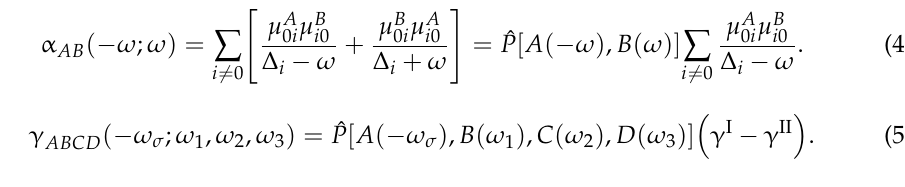
Figure 9. Vibration modes of [12,12]CNB at 929.5, 1360.3, 1482.7, 1565.3, and 3198.8 cm −1